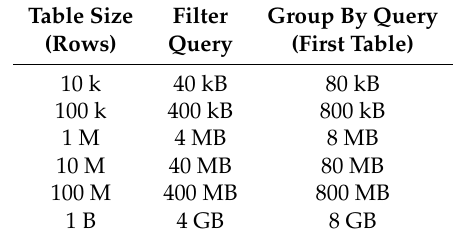
Table 2. The amount of memory needed to store the weights and row indexes per table of various table sizes. This assumes 31 bits per row index and 1 bit for a binary weight. The first table sampled in a Group By query with a join requires more bits to store the fractional weights. The remaining tables in the Group By query require the same space as a table in a Filter query if the Group By query also includes filters. Otherwise, no weights need to be stored and rows are sampled uniformly. Filter Group By Query (Rows) Query (First